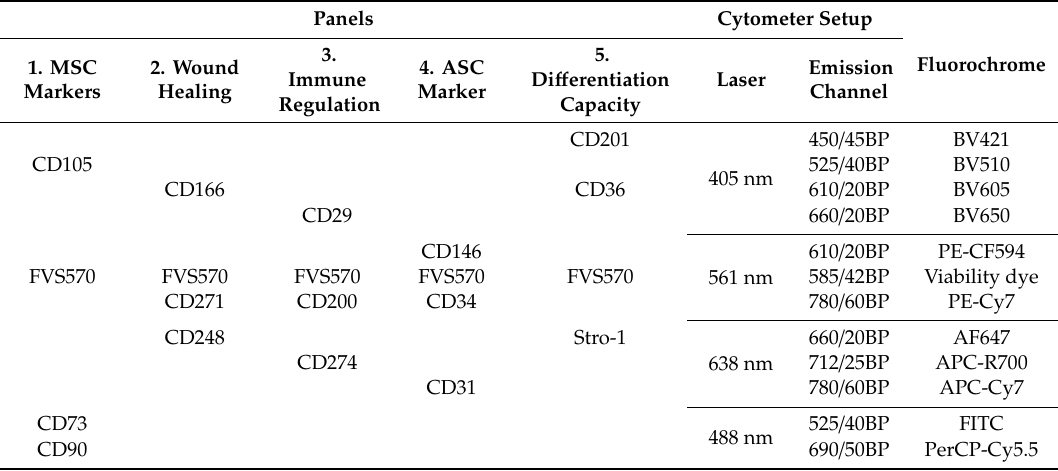
Table 1. Panel design for flow